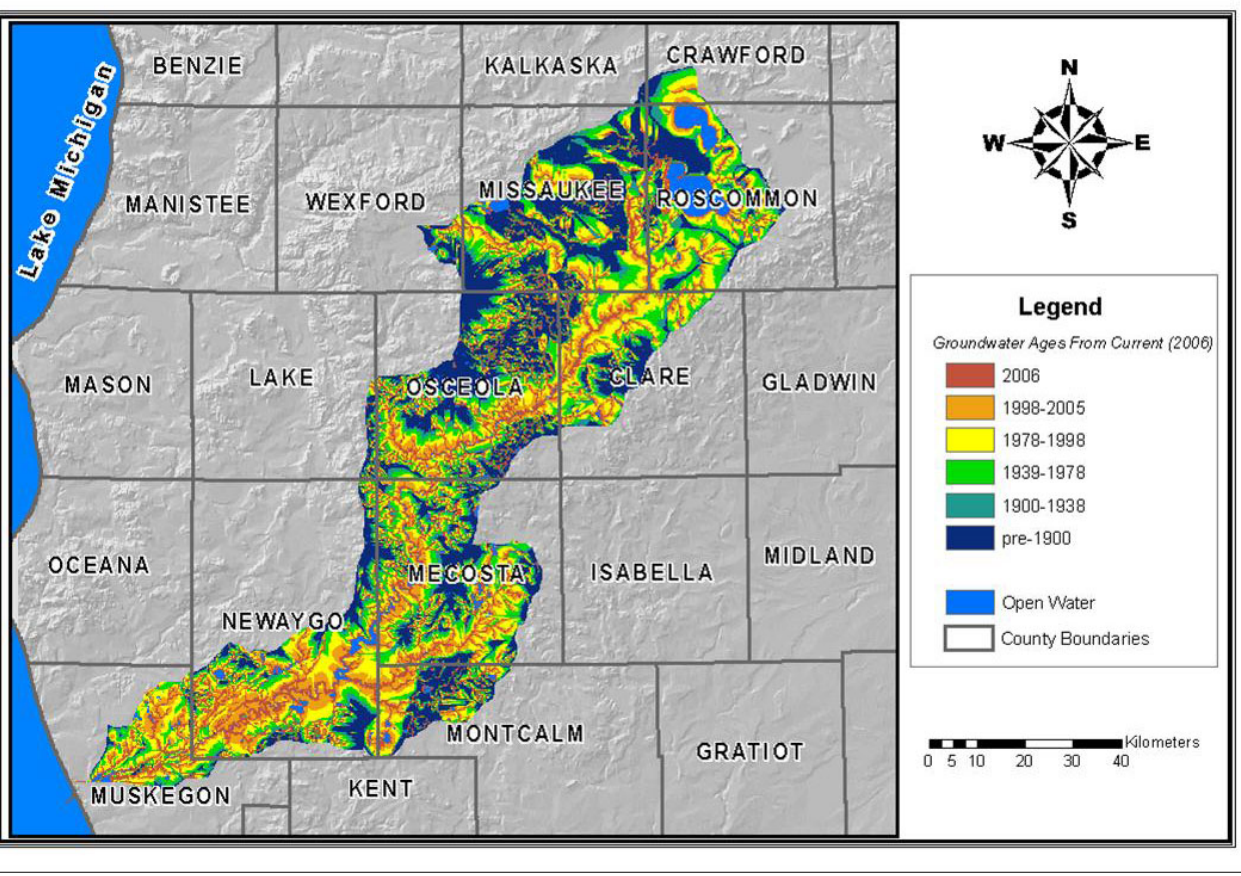
Fig. 4 . Spatial distribution of groundwater travel dates organized by the backcast land-change